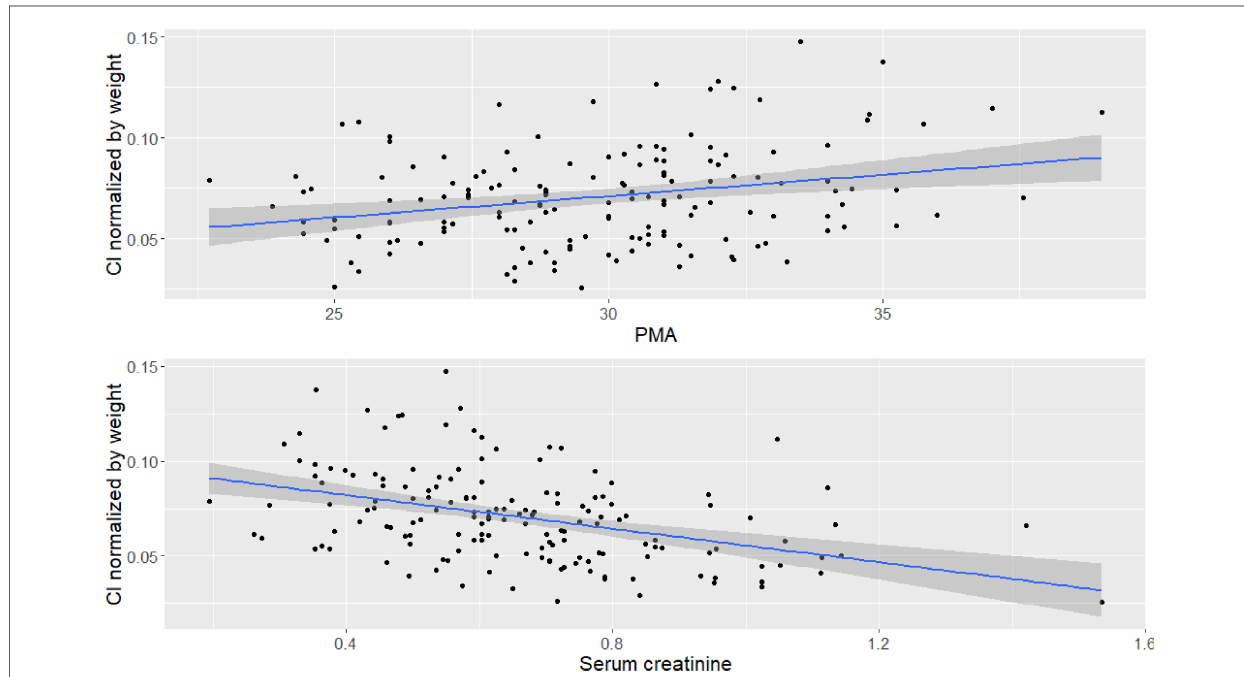
FIGURE 1 Correlation between covariates and Cl. Top fi gure is correlation between PMA and Cl normalized by bodyweight, bottom fi gure is correlation between Scr and Cl normalized by